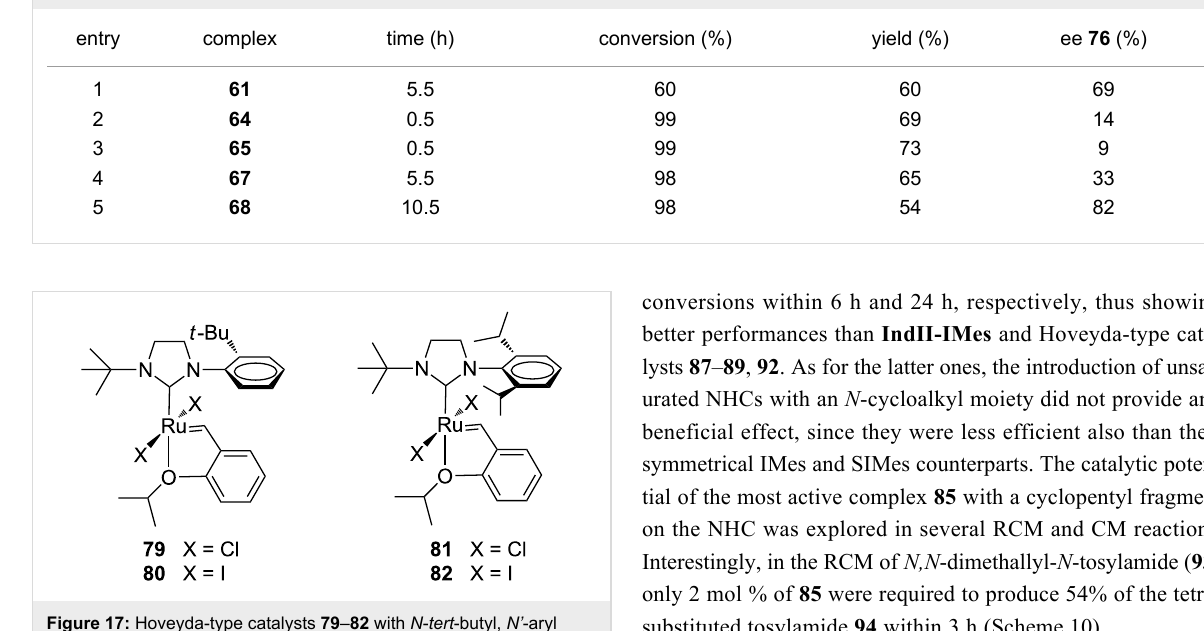
for the latent ROMP of norbornene derivatives (e.g., 83 , Scheme